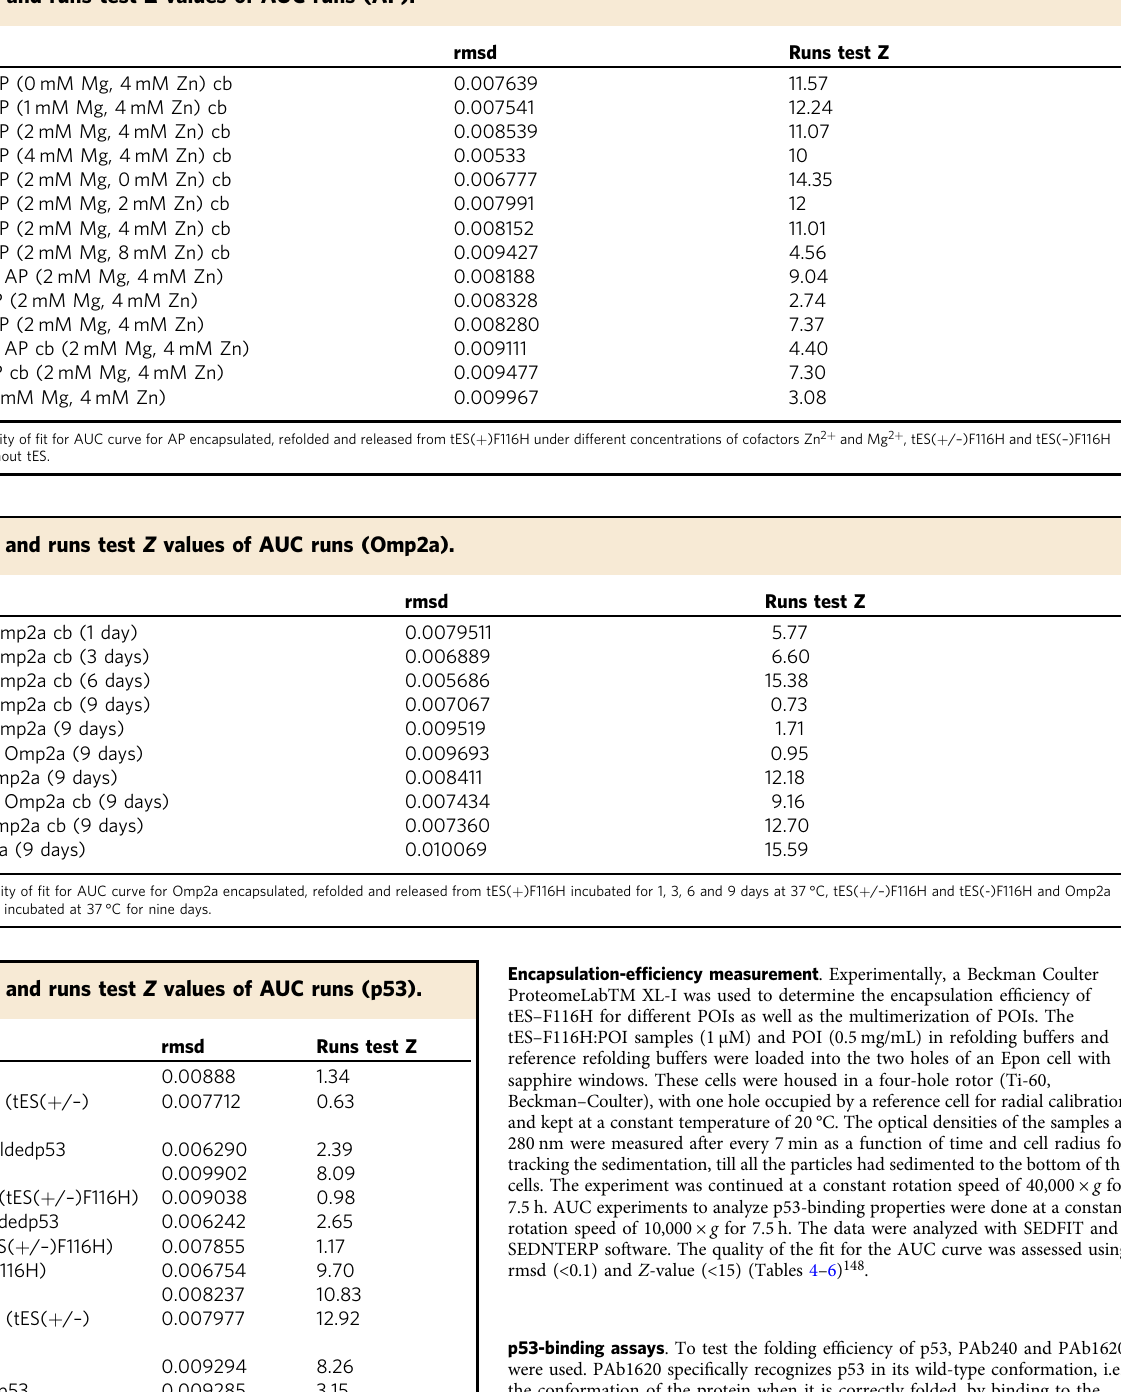
Table 4 rmsd and runs test Z values of AUC runs (AP). Protein rmsd